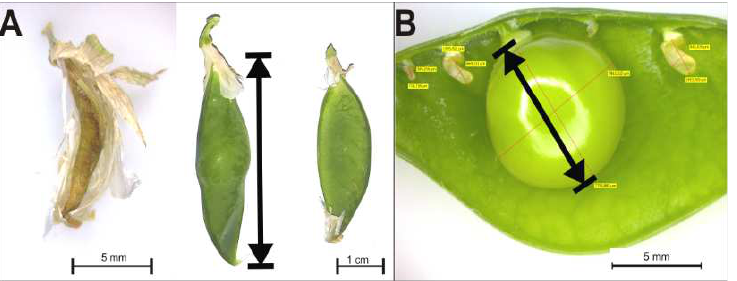
Figure 1. The type of pod ( A ) and the scheme of the measurement of pods and seeds ( B ) after 28 days of Cd-treatment. The pod and seed size were determined according to its length—black line indicator.